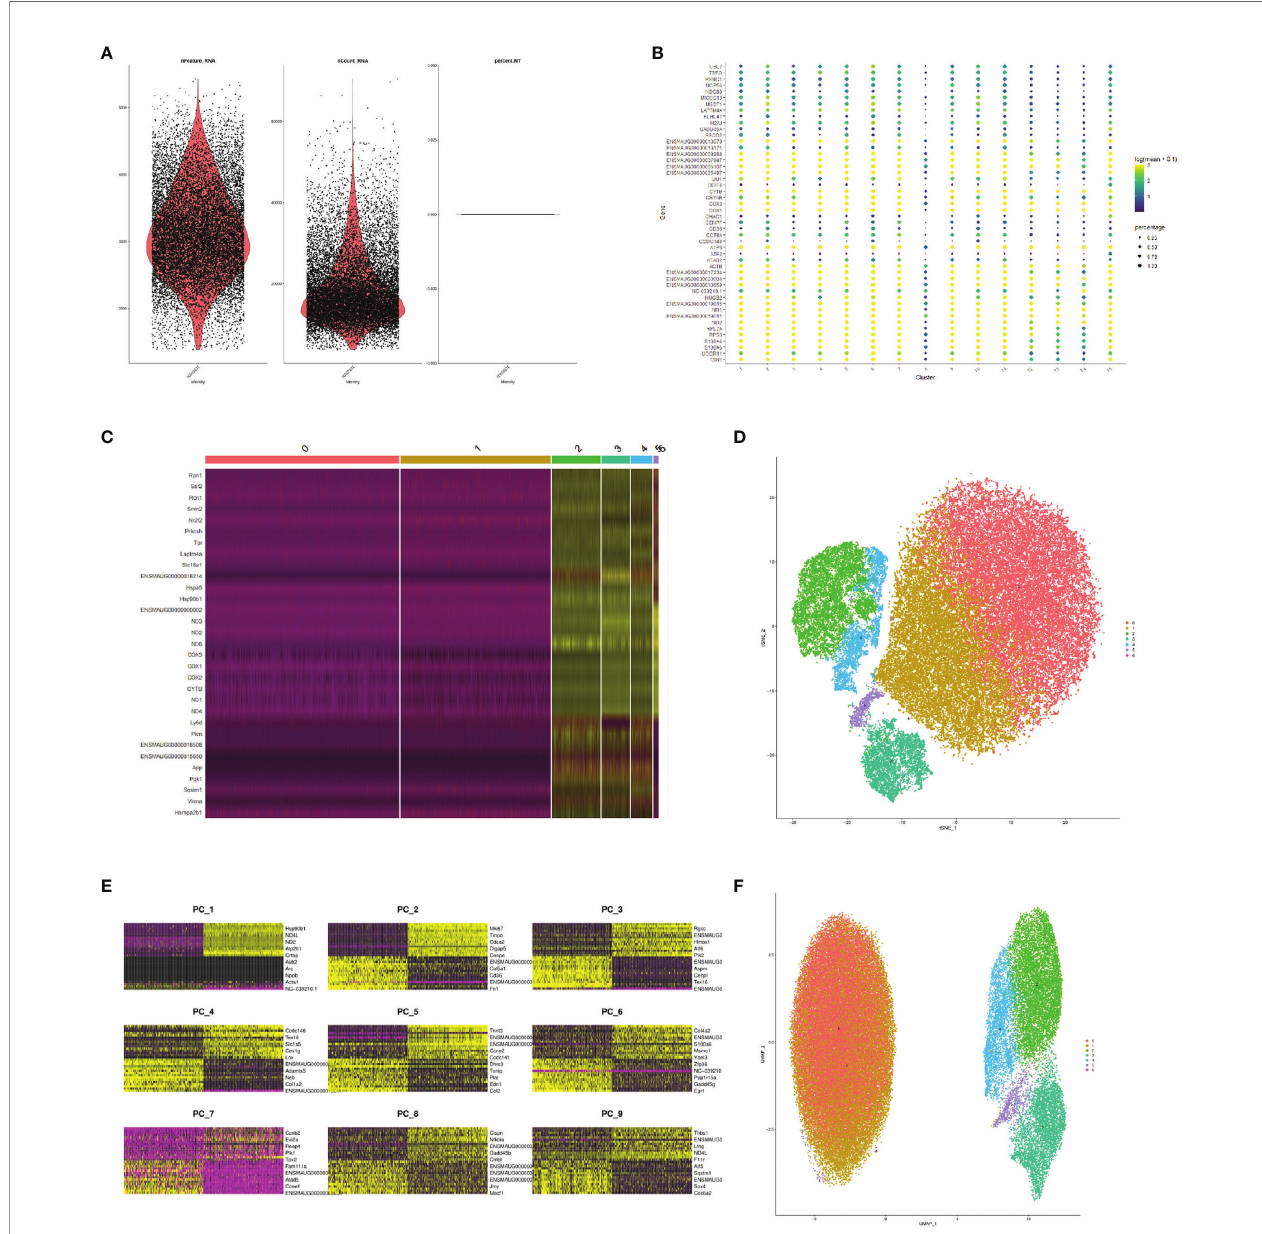
FIGURE 1 | Comprehensive FMDV-persistent infection map by single-cell sequencing. (A) Violin diagram of the quality control of single-cell sequencing. Dot diagram (B) and the heat map (C) of the gene clustering of cell subpopulations. tSNE displayed subclusters after cluster analysis (D) . Heat map of the genes in the fi rst nine principal components (E) . UMAP displayed subclusters after cluster analysis (F)